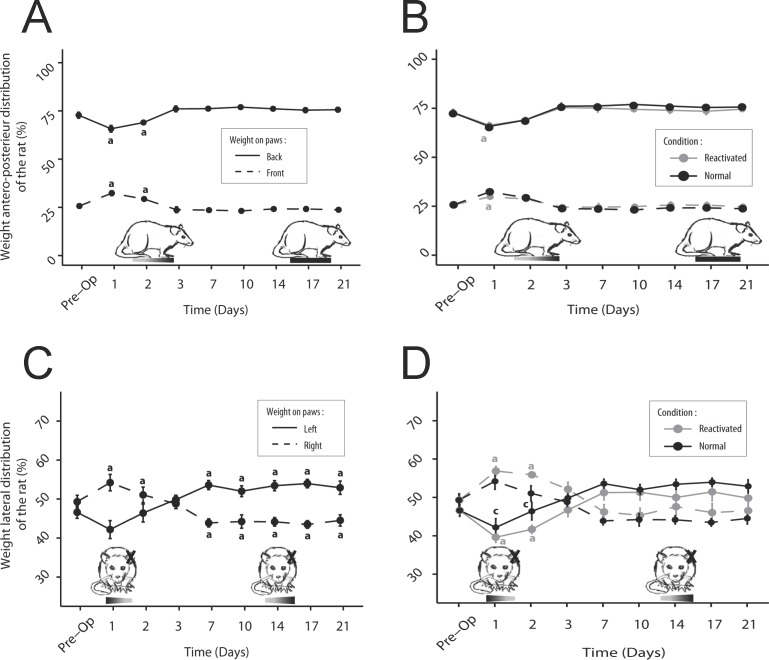
Representation of the weight distribution on each leg before and after UVN.A-B: Antero-posterior axis. Normal situation (A), after reactivation of the vestibular syndrome (B). The rat weight is transferred forward over the first few days, with a statistically significant increase at P1 in the weight applied to the front paws and a simultaneous decrease of the weight on the hind paws relative to pre-operative condition (a; p<0,05). Reactivation of the vestibular syndrome does not significantly affect the antero-posterior weight distribution. C-D: Lateral axis. Normal situation (C), after reactivation (D). The rats apply more weight on the contralateral (right) side to the UVN the first two days, with a tendency for simultaneously reducing the weight on the opposite paw. This trend is reversed from P7 and maintained over the 3 weeks period monitored (in both cases: statistically significant difference relative to the pre-operative condition a; p<0,05). Reactivation of the syndrome affects only the weight distribution until D2 (c, p<0,05).